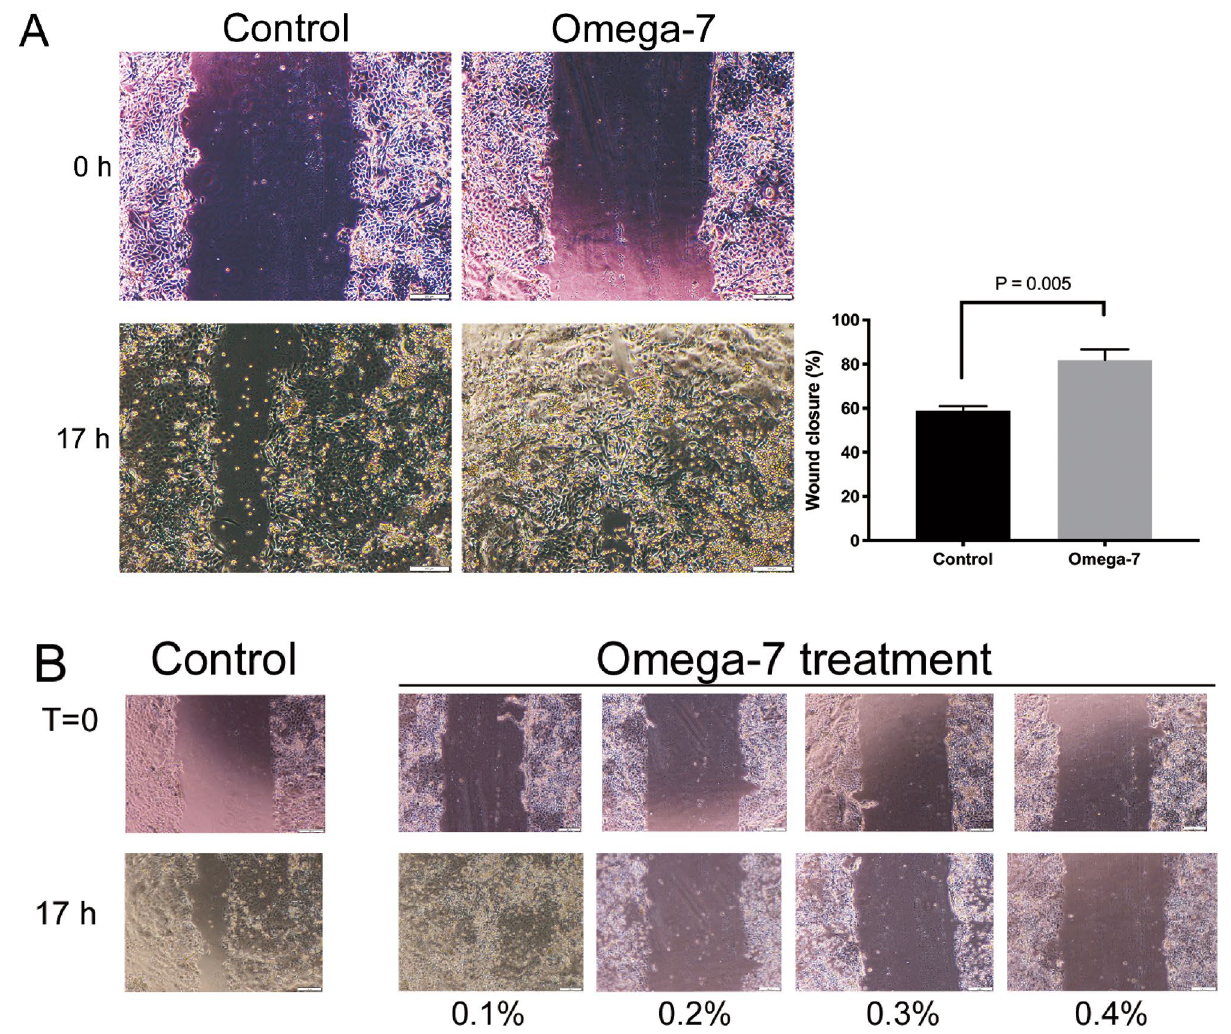
Figure 2. Cultured keratinocyte migration assay. ( A ) Effects of 0.08% Omega-7 on the cultured keratinocyte migration rate 17 h after the scratch. ( B ) Effects of Omega-7 (0.1, 0.2, 0.3, and 0.4%) on cultured keratinocyte migration rate. The scratch was performed when the cells were grown confluently. The Omega-7 was added to the confluently grown cells immediately after the scratch. Omega-7 had a negative effect on the keratinocyte migration with dose greater than 0.1%. The cells were assessed in 12 dishes (6 treated and 6 controls). Data are expressed as mean ± SEM. Scale bar in micrographs: 200 μm. Photographs taken and compiled, by authors, in Adobe Photoshop CC 2020 (https ://www.adobe .com/jp/produ cts/photo shop.html) without changing the content of images